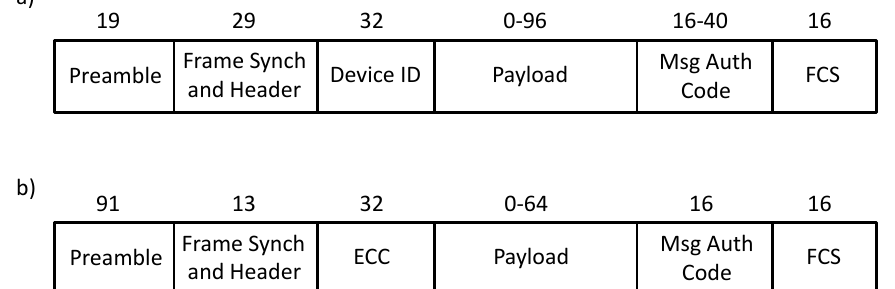
Figure 3. ( a ) Unidirectional and ( b ) bidirectional transactions in Sigfox.